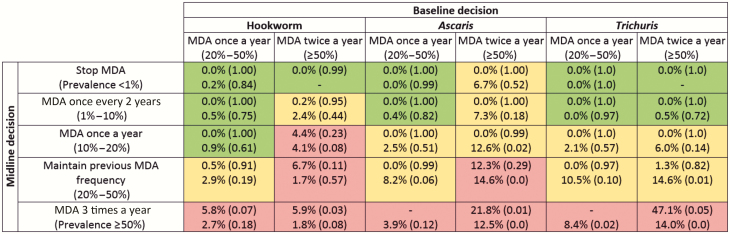
Prevalence of moderate to heavy soil-based helminth infection in school-aged children (SAC) after 10 years of treatment under current guidelines assuming 75% coverage in SAC, highlighted by achievement (green) or otherwise (red) of 1% prevalence goal, or varying predictions between models (yellow), in various transmission settings. Results in each cell have Imperial College London results at the top and Erasmus Medical Center Rotterdam below. Figures in parentheses are the probability of measuring a prevalence of medium- and high-intensity infections <1% from a sample of all SAC. Decisions are based on measured prevalence of infection and correspond with World Health Organization recommendations [1]. Abbreviation: MDA, mass drug administration.